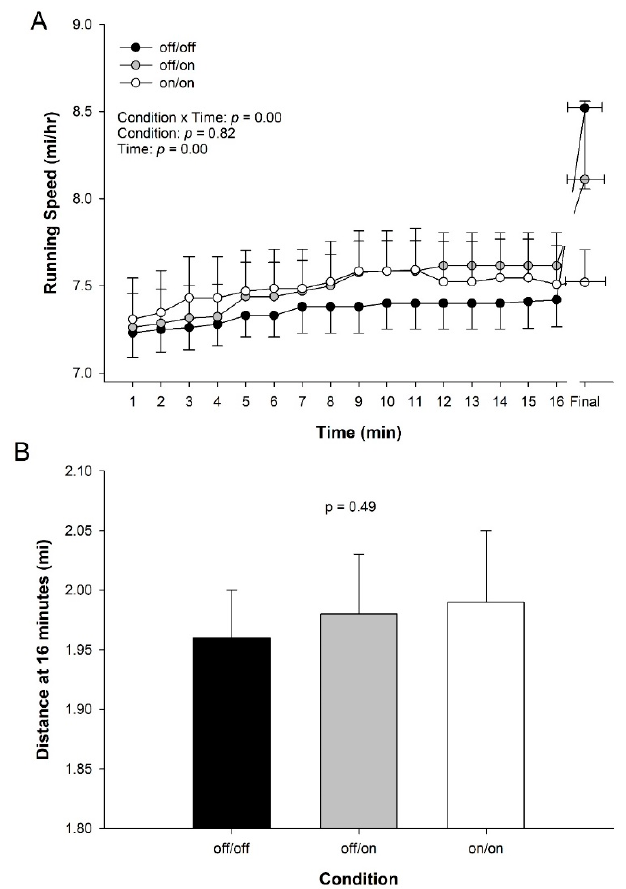
Figure 4. Running performance across wrist percooling condition. ( A ) Self-selected running speed during the 10 km time trial in the heat. Results of two-way ANOVA are presented (inset). Note: due to safety tolerance in core temperature trials were ended early and plotted to the shortest time, plus each athlete’s final data point (with SE for time). (B) Distance to 16 minutes across wrist percooling condition ( n = 13). This time was chosen as it was the longest point to which all participants completed at least 16 min for all 3 trials. Data are means ± Standard Error.